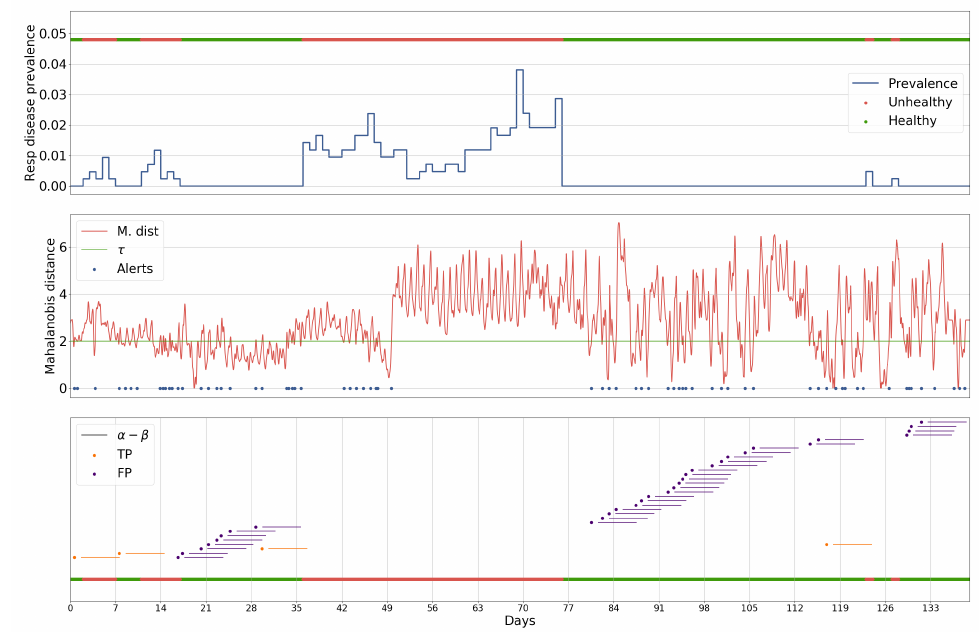
Figure 9. Results for batch 27 processed by the GRU-autoencoder-powered anomaly detection, given its PSO-optimised parameters α (the start of the window for which an alert is for), β (the length of the window), and τ (the threshold which the loss between predicted values and actual values must cross to be considered an alert), in relation to the prevalence of respiratory disease within a single